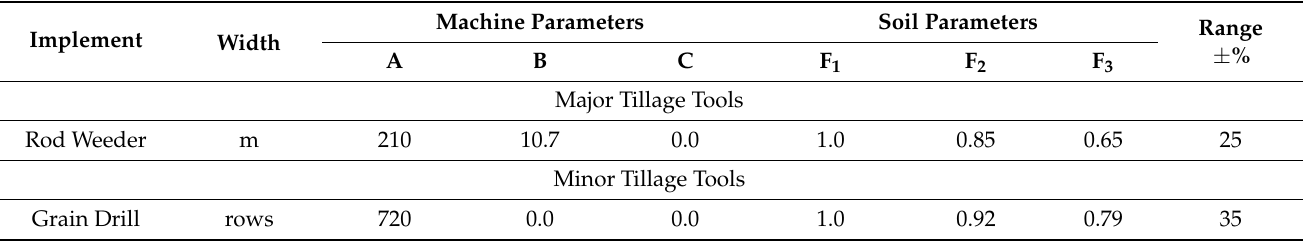
Table 3. Machine and soil parameters for rod weeder and grain drill